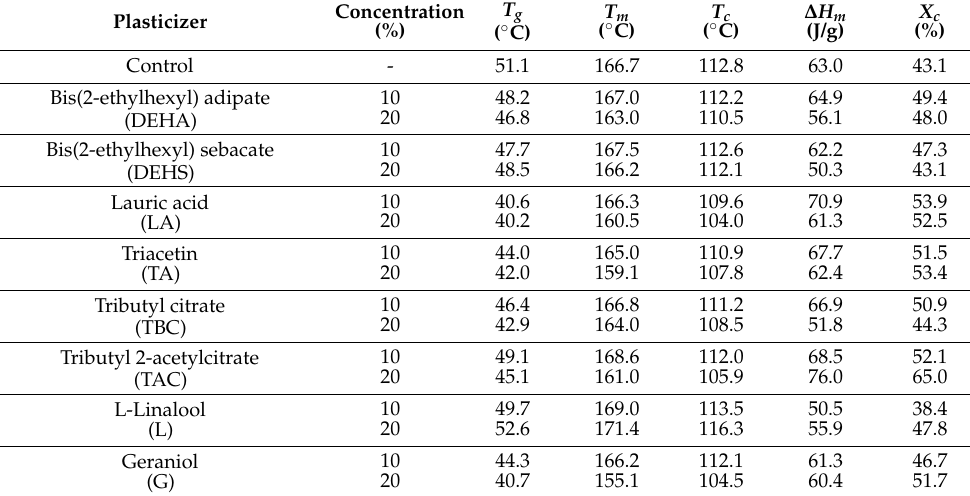
Table 2. Thermal properties of plasticized PHB analyzed by using